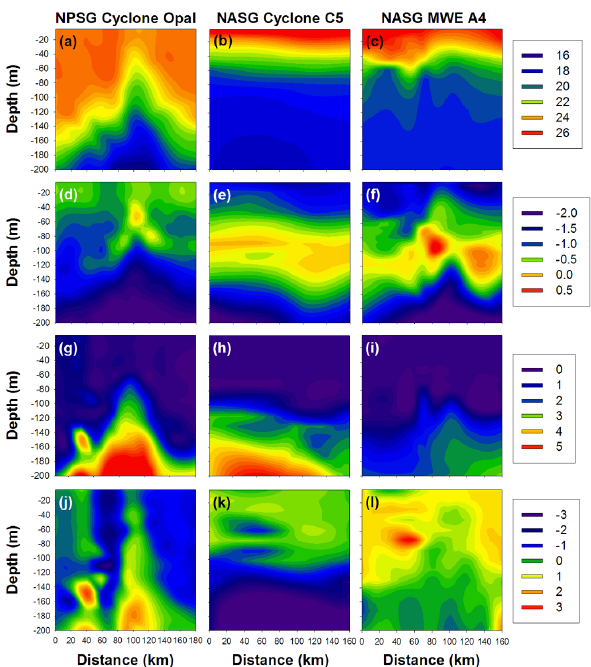
Fig. 1. Comparison of physical and chemical features in transects of vertical profiles (0–200m) through the physical centre of three eddies. (a–c) show transects of temperature ( ◦ C), (d–f) transects of total chlorophyll- a (mgm − 3 ; shown on a log scale), (g–h) transects of total dissolved nitrate (µmoll − 1 ) , and (i–l) Si ∗ (µmoll − 1 ) . Cy- clonic eddy Opal was sampled close to Hawai’i in the NPSG (March 2005), while cyclonic eddy C5 and MWE A4 were sampled in the Sargasso Sea NASG, (June–August 2005). Fig. 2. Comparison of temperature and salinity profiles (a) and temperature-depth profiles (b) from the central station MWE A4 (white dots) and Cyclonic eddy C5 (black